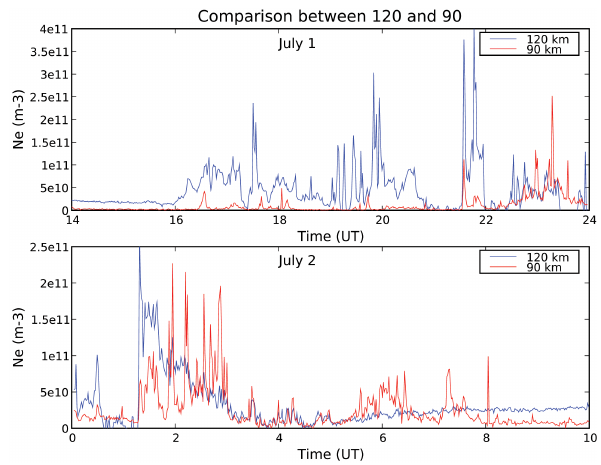
Fig. 2. Comparison between E- (120km) and D- (90km) region